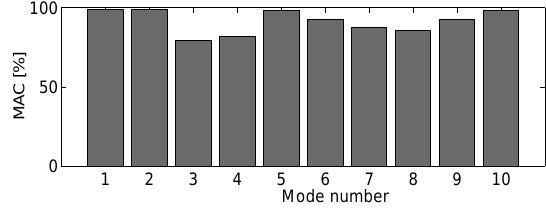
Fig. 7. Mode correlation of the initial model ( MAC init = 91 . 4% ).